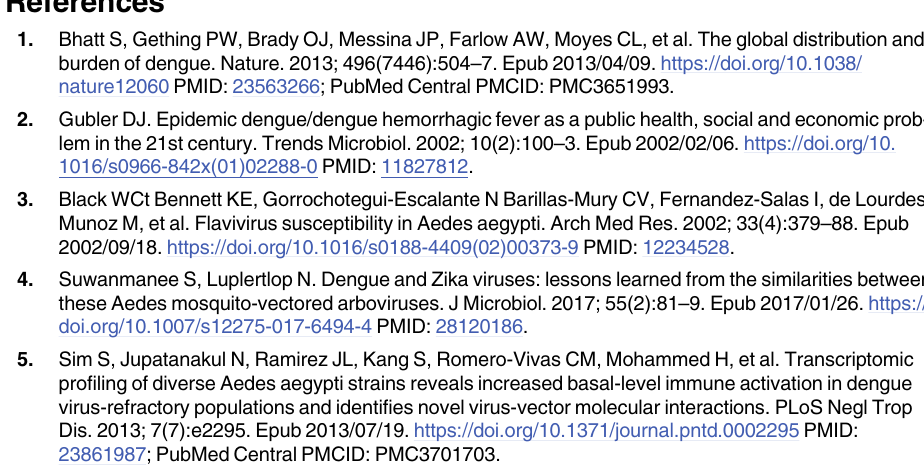
S1 Raw Images. The gel picture of Fig